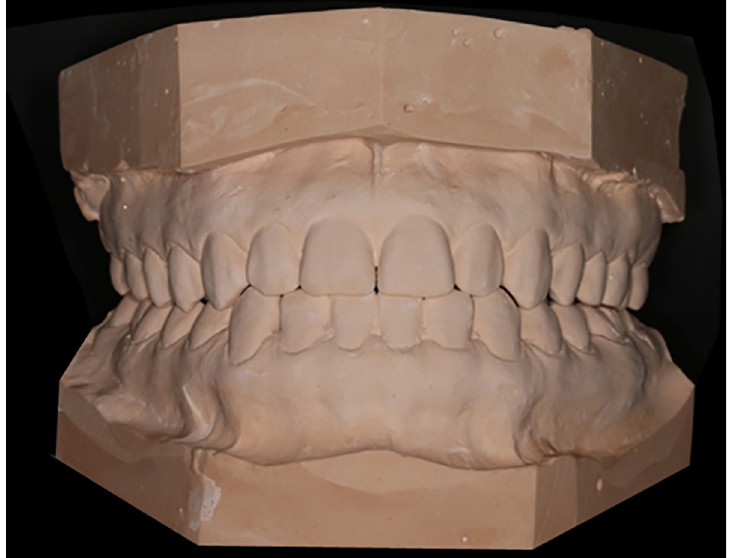
Fig 1. Gypsum model with uniform perfusion.